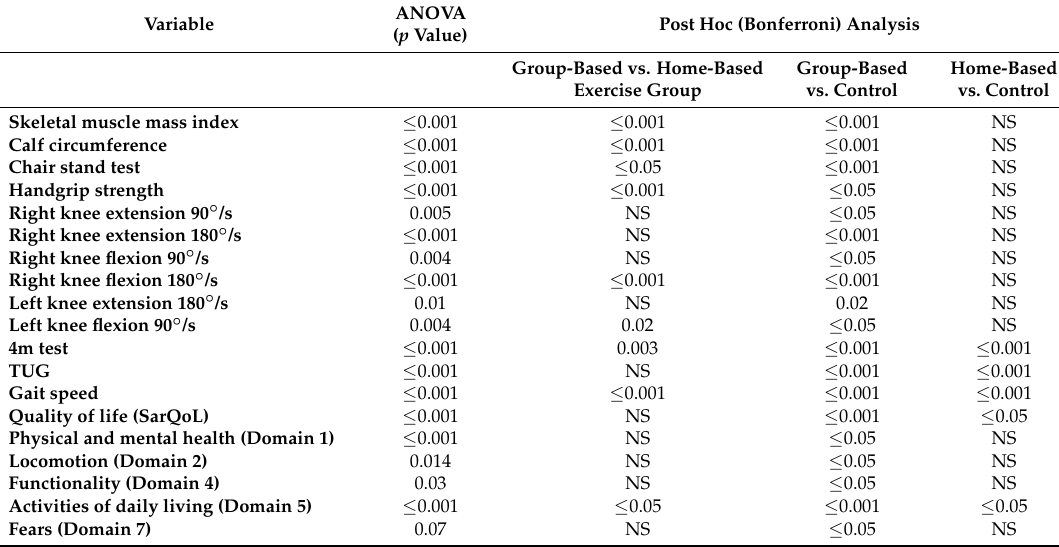
Table 5. Between-group comparisons at 12 weeks.